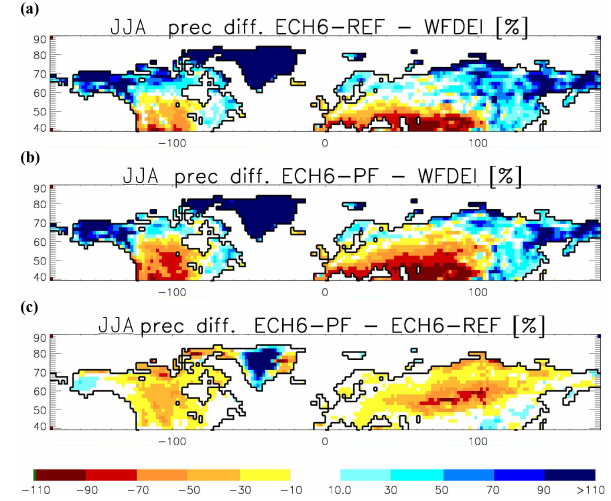
Figure 1. Boreal summer (JJA) precipitation differences (%) rela- tive to WFDEI data for (a) ECH6-REF, (b) ECH6-PF, and (c) dif- ference between ECH6-PF and ECH6-REF (in % of WFDEI pre-